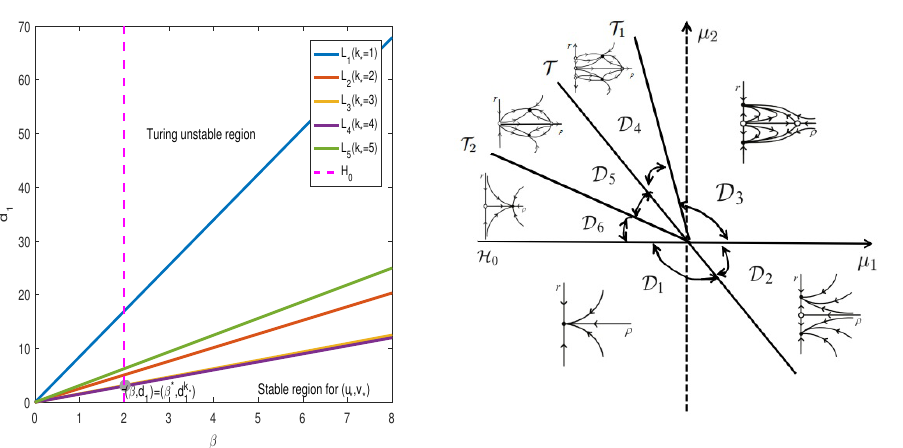
) and some curves in the d 1 , v ∗ ∗